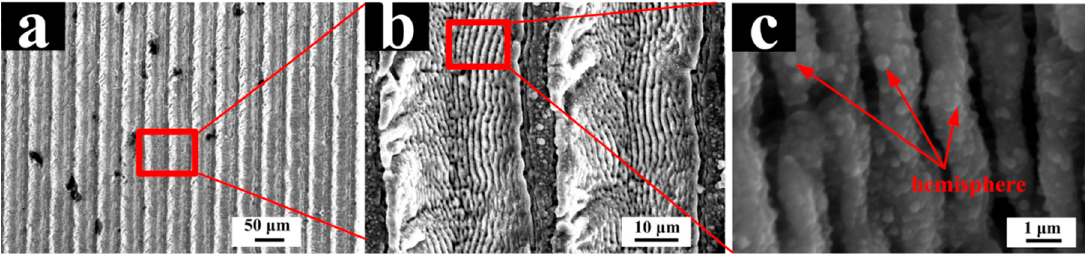
Figure 8. LIPSS induced on the Ti-6Al-4V surface with a laser energy density of 0.218 J/cm² and scanning speed of 40 mm/s. ( a ) Periodic ripples; ( b ) enlarged view, ×1500; ( c ) enlarged view, ×13,000.